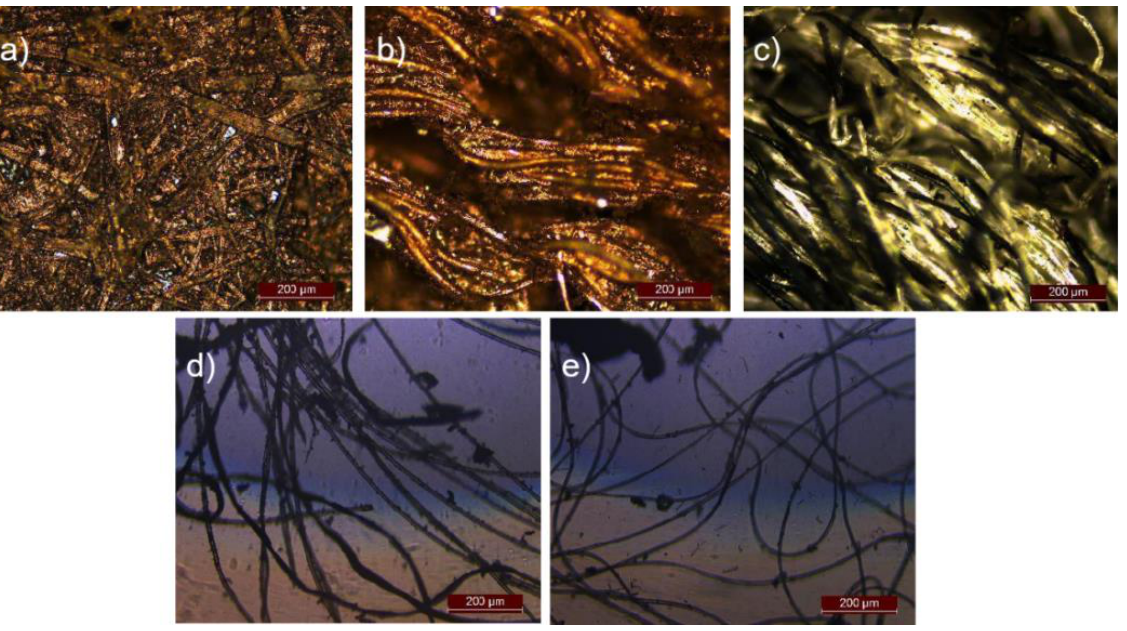
Figure 4. Polarizing optical microscope images of PPy composite ( a ) paper; ( b ) non-dust cloth; ( c ) linen; ( d ) cotton; ( e ) wool.